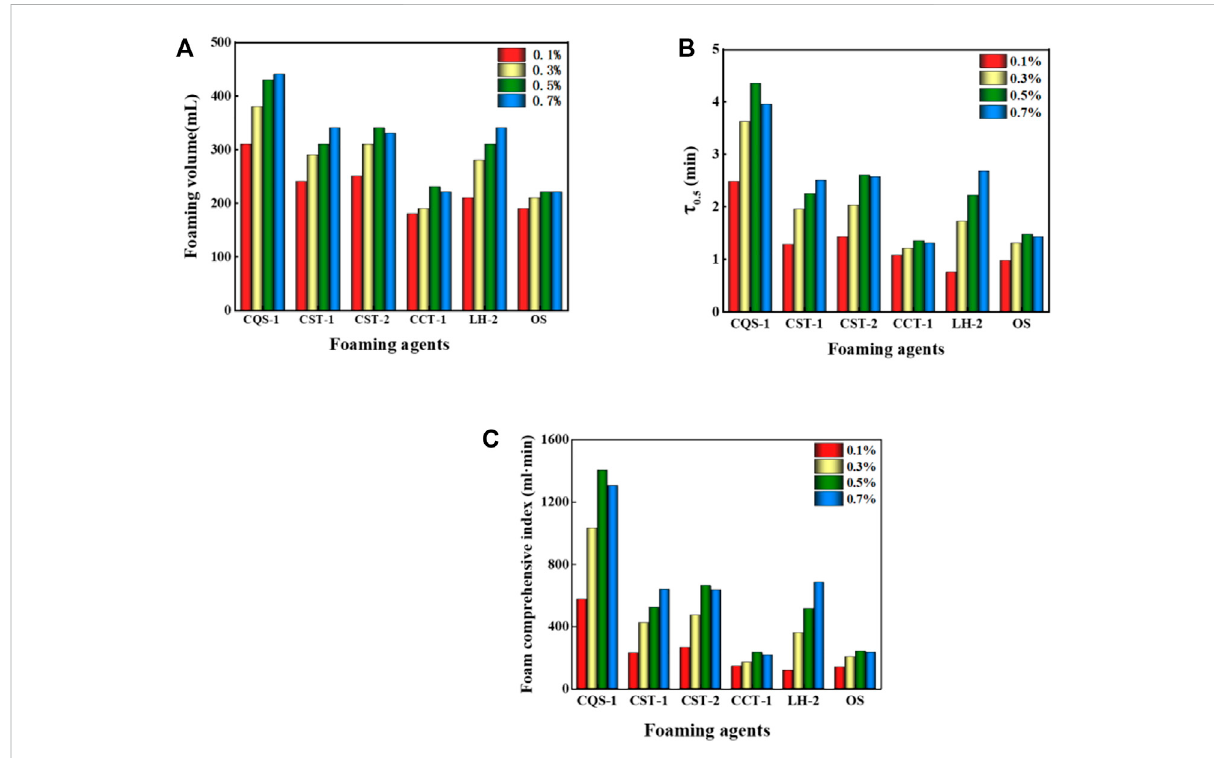
FIGURE 3 (A) Volumes of different foams with different concentrations. (B) The half-life of different foams with different concentrations. (C) Comprehensive indices of different foams and